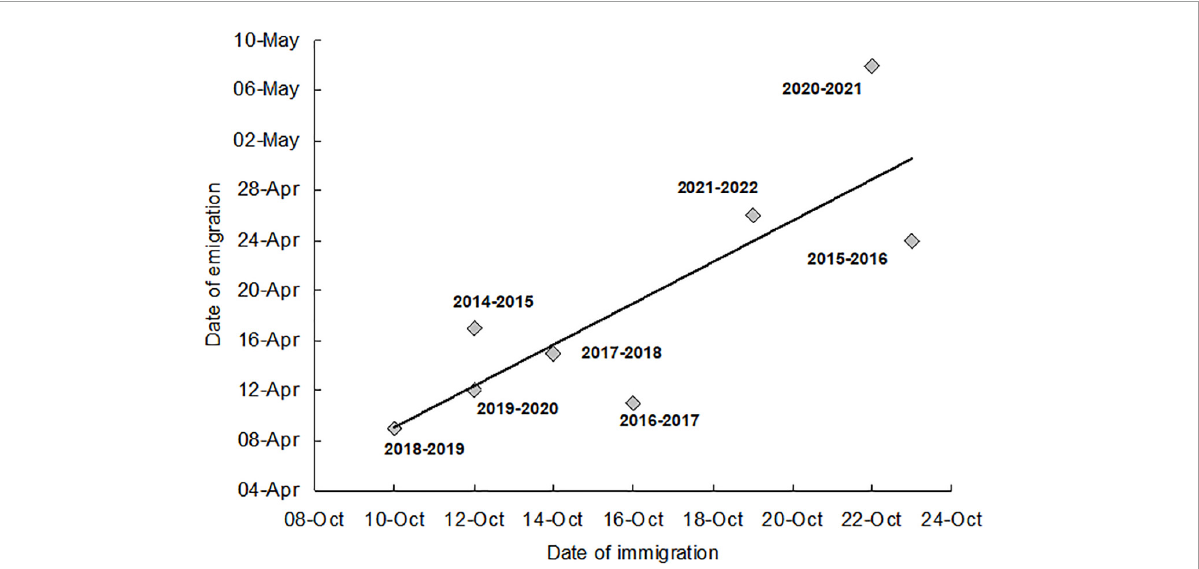
FIGURE7 Dates of emigration from the artificial hibernaculum (the day when 50% of individuals left the artificial hibernaculum D 0 . 50 , abscissa), plotted against the dates of immigration to overwintering sites (day of massive migratory flight activity, ordinata). The symbols indicate the hibernation period from which the dates of immigration and emigration originate. y = 42.369 + 1.488x, N = 8, R 2 = 0.600, P =